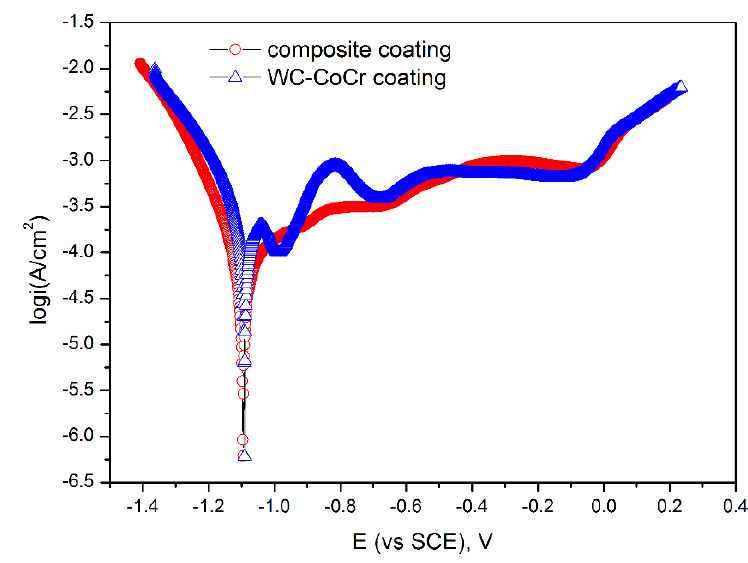
Figure 12. Potentiodynamic polarization curves of the as-sprayed coatings in 1 M NaOH solution. Table 4. Electrochemical parameters derived from the polarization curves of the as-sprayed coatings in 1 M NaOH solution.